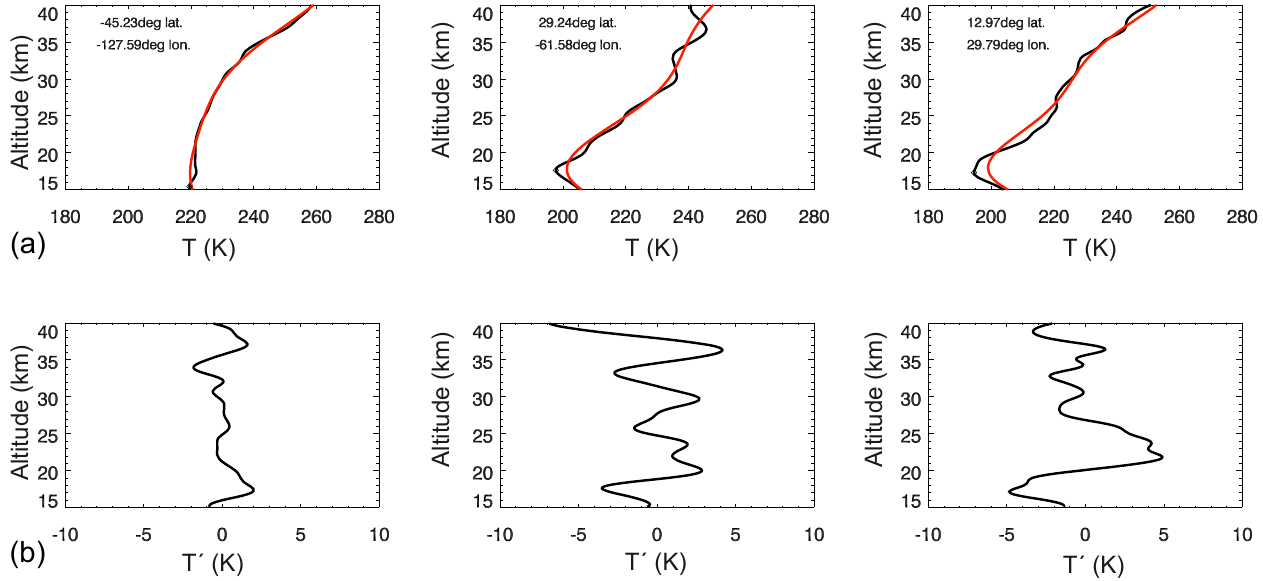
Figure 5. (a) Sample radio occultation temperature profiles from December 2015 (black lines) with background profiles (red lines) as determined with a fifth-order Butterworth filter with 15km cutoff wavelength following Ehard et al. (2015). (b) Corresponding temperature perturbation profiles (radio occultation profile minus background